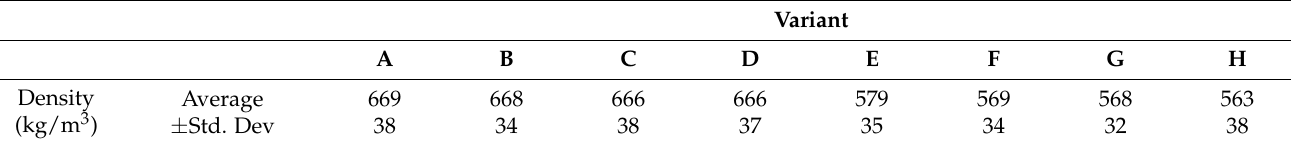
Table 4. Average density of manufactured particleboards.